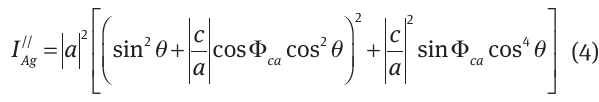
tion; and γ is the angle between the scattered light polari- zation and the zigzag orientation.